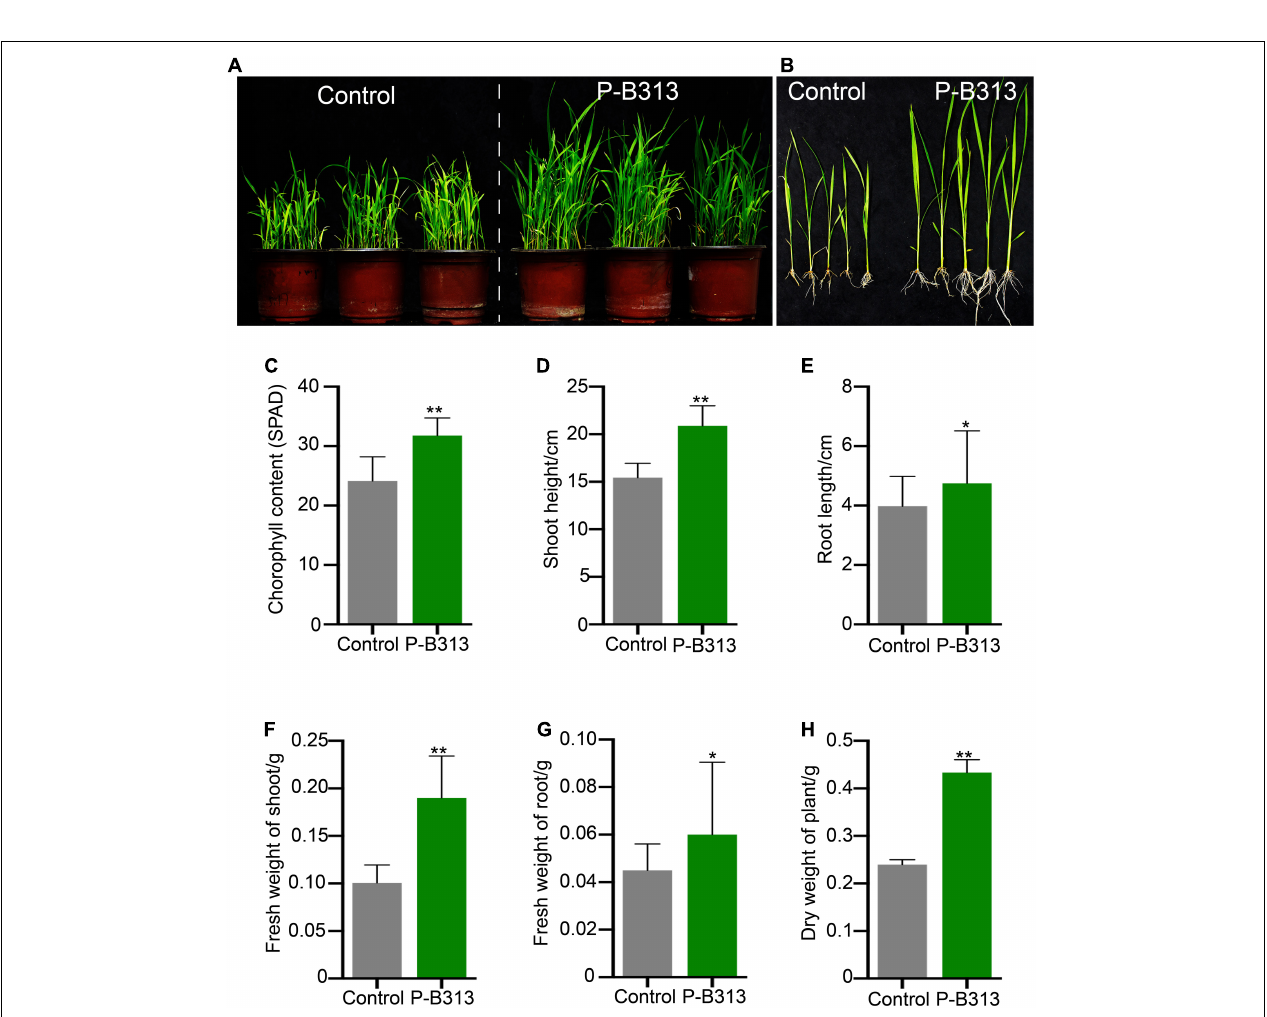
FIGURE 5 | Effect of P. oryzae on the rice growth in pots. (A,B) The comparison of P. oryzae -treated plants with control in pots. (C–H) The comparison of P. oryzae -treated plants with non-treated control on the growth parameters includes the chlorophyll content, shoot height, root length, fresh shoot weight, fresh root weight, and plant dry weight. All the above bar charts were plotted with Mean ± SD. Independent-samples t -test analyzed data. The symbols * and ** indicate significant differences at P < 0.05 and P < 0.01, respectively.